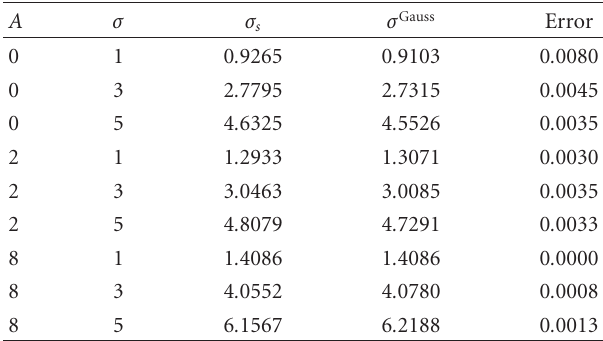
Table 1: Accuracy of Gaussian fits to the PDF C A , σ for various values of A and σ . Shown are the exact standard deviation σ s computed from (11), the width σ Gauss of the fitted Gaussian, and the mean square error of the di ff erence between the exact distribution and the fitted